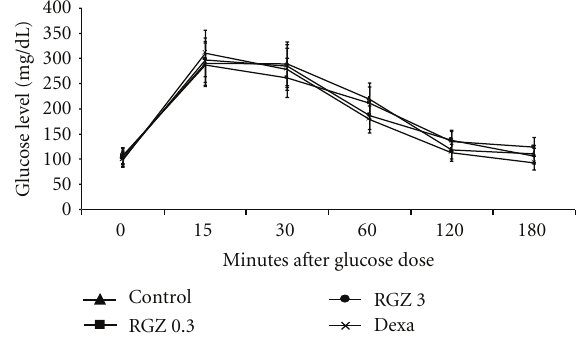
Figure 2: E ff ect of RGZ on glucose tolerance test (GTT). At 12 weeks of age, glucose was administered at 1g/kg body weight i.p. after an overnight fast. Glucose was assayed at time = 0 (baseline), 15, 30, 60, 120, and 180 minutes following glucose administration. There were no significant di ff erences ( P > 0 . 05) in timed serum glucose values in the treated groups compared with controls during the GTT.